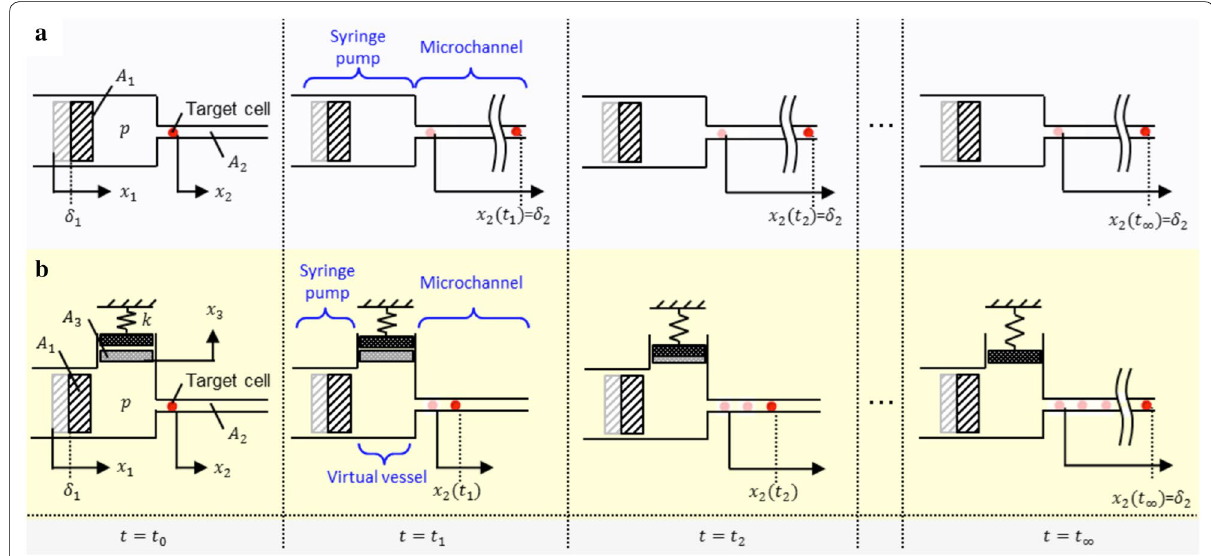
Fig. 4 Simple model for a the macroactuator system and b the system with “virtual reduction gear” (The figure is taken from [53] (reproduced under CC BY-NC-SA 4.0, see the reference for